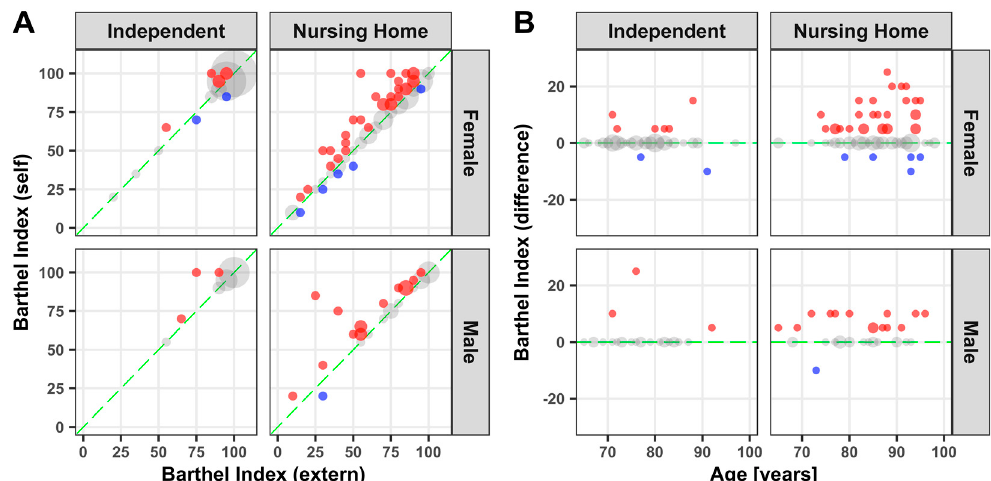
Figure 2. Barthel Index: Point plot illustration of self and external assessment of the Barthel Index ( A ) as well as the difference against age ( B ). Grey dots: no difference; blue dots: underestimation; red dots: overestimation. Dot size represents the relative number of participants.